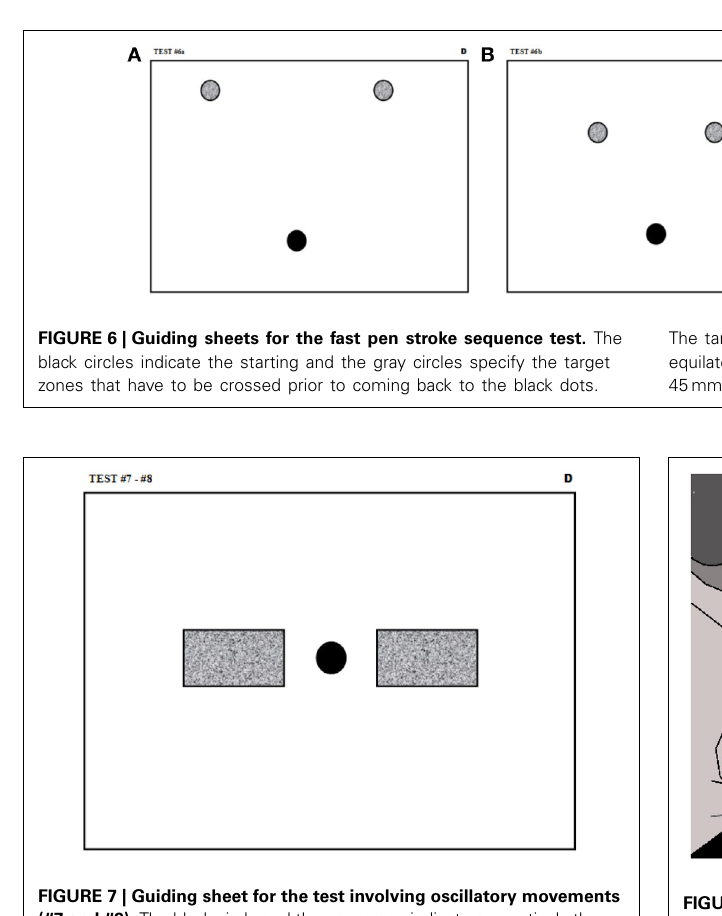
FIGURE 8 | Experimental setup showing the subject sited comfortably and ready to make a movement over the Wacom tablet (B) as soon as the stimulator (A) gives the cue. Reproduced, with slight modifications, from O’Reilly et al.